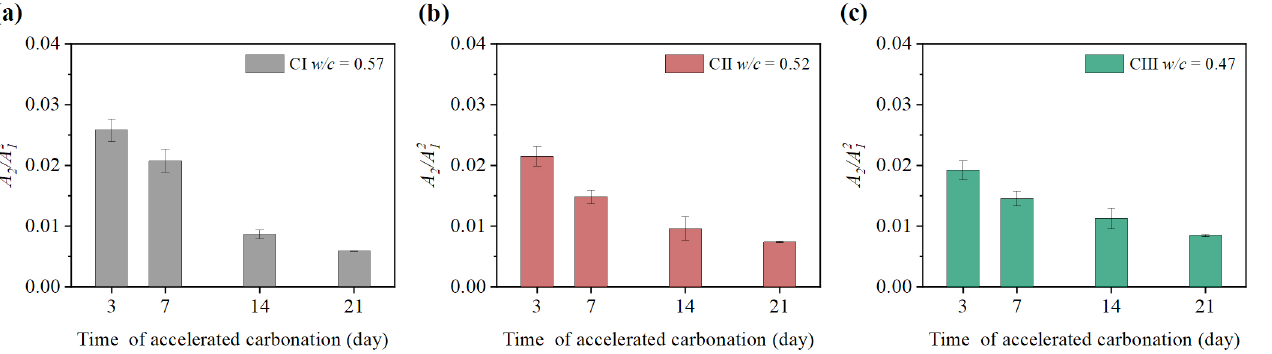
of CII; ( c ) nonlinear parameter A 2 / A 2 1